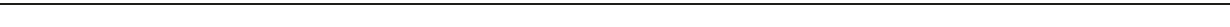
Fig. 2 MOB1 binds differently to the NTR domains of NDR2 and LATS1 through key residues. a Structure based sequence alignment of the conserved N- terminal regulatory domain of NDR/LATS kinases that is required for MOB1 binding. NDR2 residues mediating interactions with MOB1 are marked with red circles . Residues mediating intramolecular interactions of NDR2 are denoted by blue triangles . Residues conserved from yeast to humans are highlighted in green , while residues conserved in at least seven of the conserved NDR/LATS family members are marked in cyan . α helices are indicated with gray rods . b Asp63 of MOB1 is involved in LATS1 binding, but does not contribute to the interaction of MOB1 with NDR2. MOB1 is shown in yellow , while NDR2 and LATS1 are indicated in green and cyan , respectively. Top panel , Phe31 of NDR2 does not interact with Asp63 of MOB1. Bottom panel , His646 of LATS1 forms a hydrogen bond with Asp63 of MOB1. c – f Isothermal titration calorimetry ( ITC ) assays measuring the dissociation constant ( K d ) of indicated non- phosphorylated full-length MOB1 or MST2-phosphorylated MOB1 (phospho-MOB1) with wild-type and mutant NDR2 (25 – 88) or LATS1 (640 – 703) variants. MOB1/NDR2 complex formation was dramatically increased by prior phosphorylation of MOB1 c . ITC measurements could not detect any interaction between LATS1 wild-type and non-phosphorylated MOB1, while phospho-MOB1 bound to LATS1 d . The NDR2(Y32V) mutant did not associate with non-phosphorylated MOB1, but bound to phospho-MOB1, although with a 20-fold decreased binding af fi nity compared to wild-type NDR2 ( e ). The mutation of Val647 to Tyr of LATS1 enabled LATS1 to bind to non-phosphorylated MOB1, and LATS1(V647Y) displayed a 5-fold increased binding af fi nity for phospho-MOB1 compared to wild-type LATS1 ( f